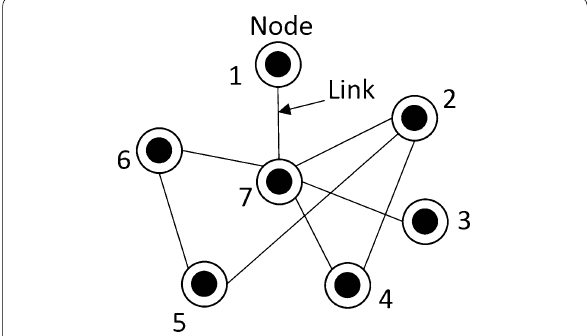
Fig. 1 Concept of a network